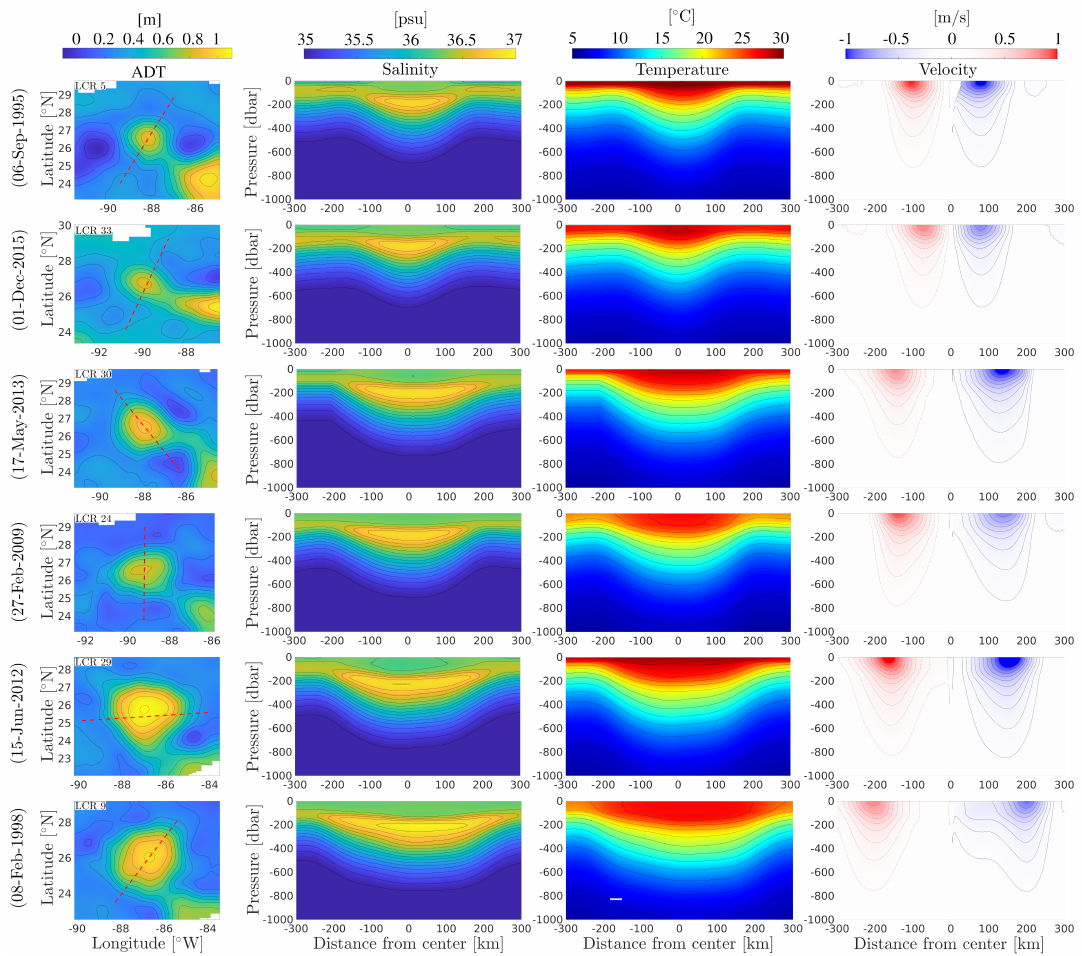
Figure 8. Selected examples of LCRs three-dimensional structure reconstructed from altimetry and the GEM method. ( First row ): maps of absolute dynamic topography (ADT). The dotted red line represents the trajectory of the virtual vertical sections. ( Second row ): Vertical sections of salinity. ( Third row ): Vertical sections of temperature. ( Fourth row ): Vertical sections of cyclogeostrophic